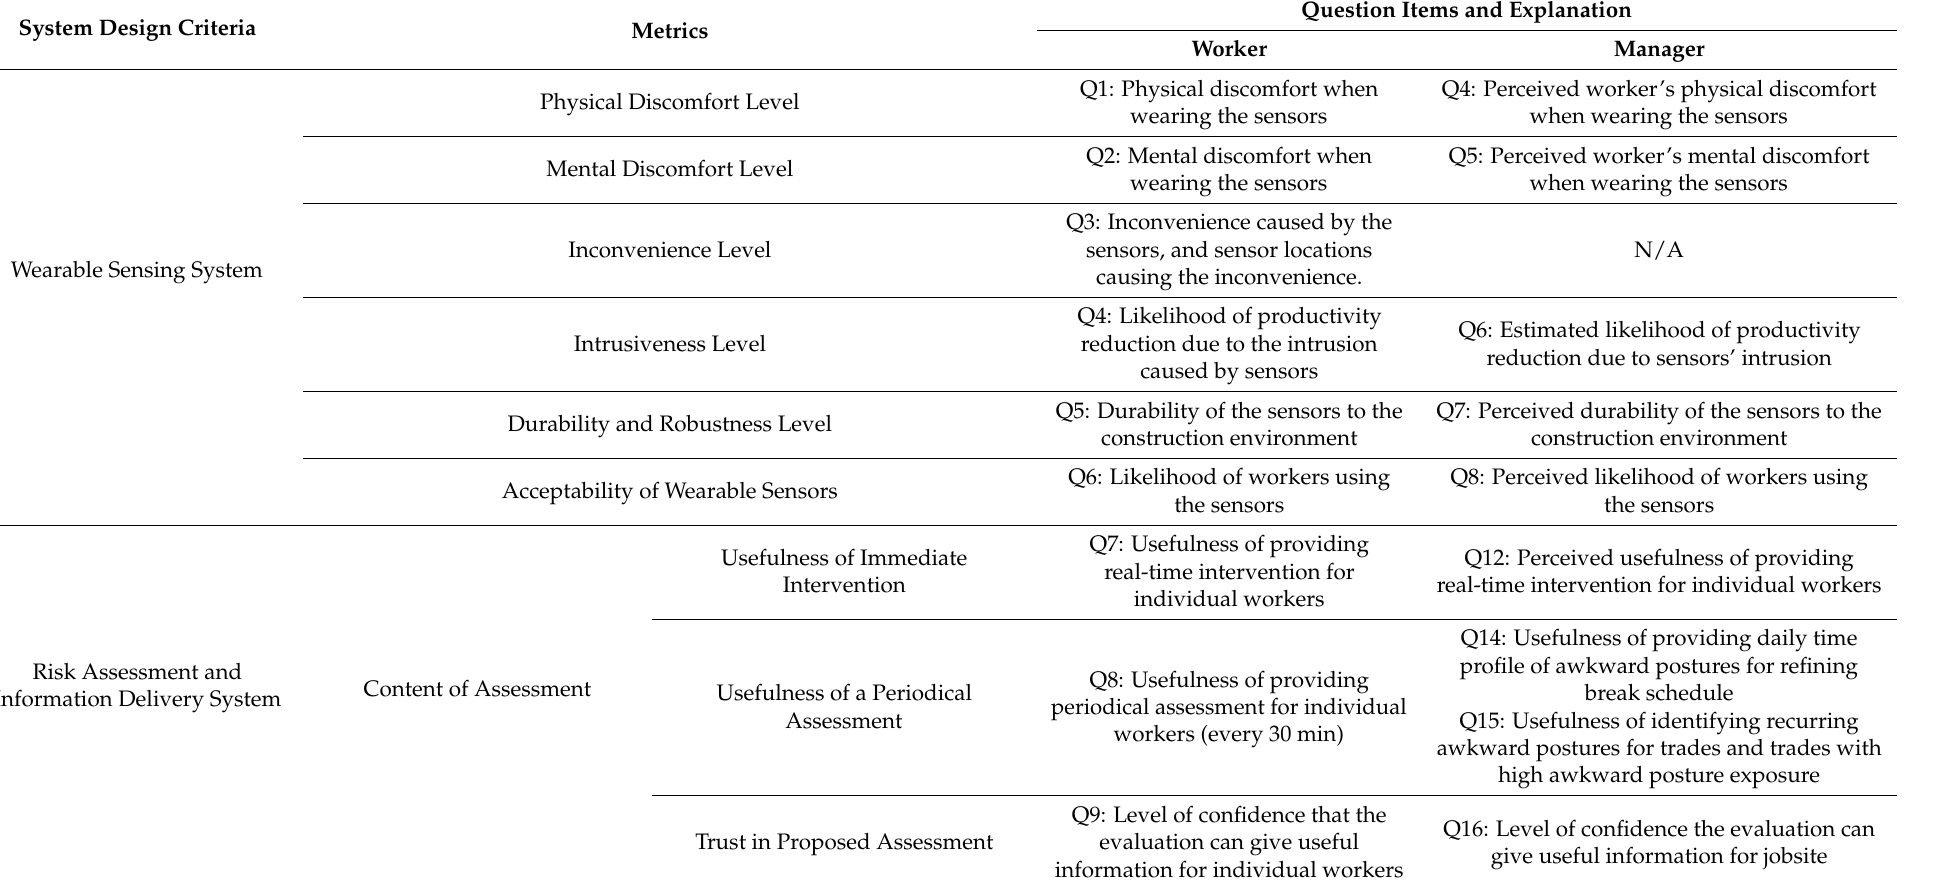
Table A4. Evaluation survey question